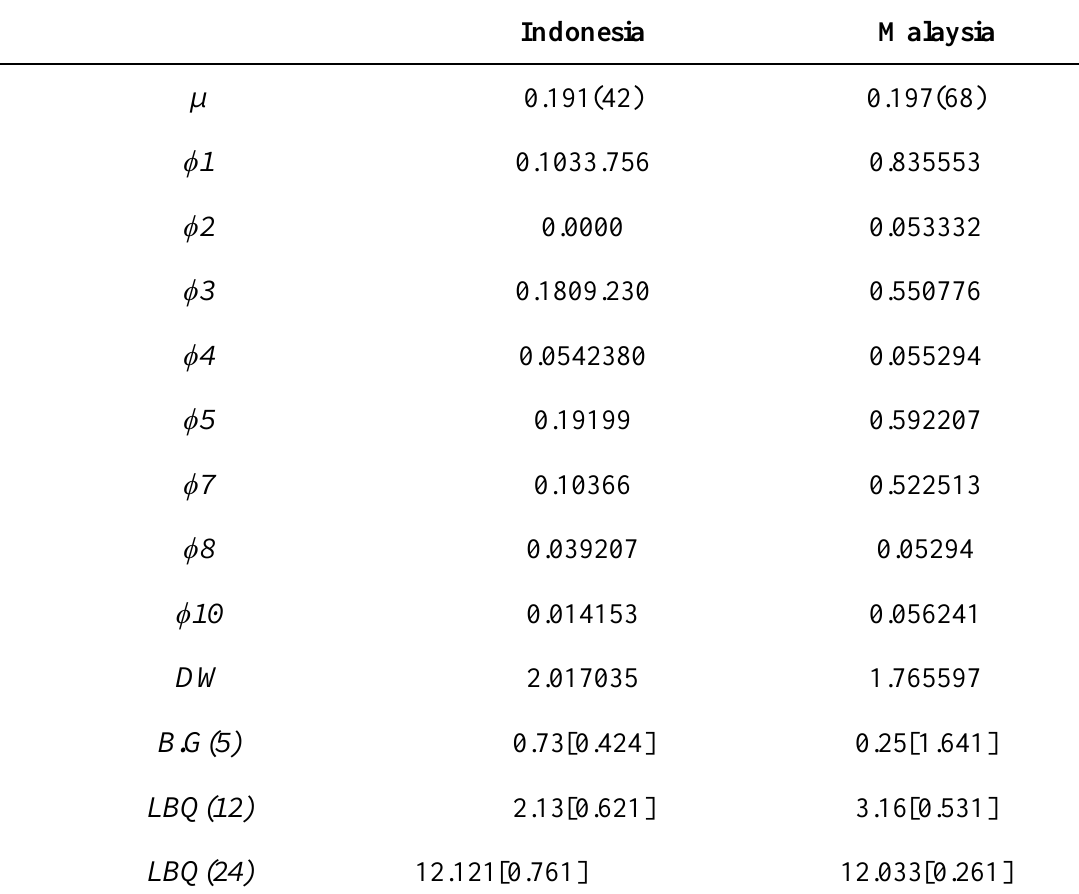
Table 4. AR (p) Pre-Whitening MODEL (Indonesia and Malaysia Shariah